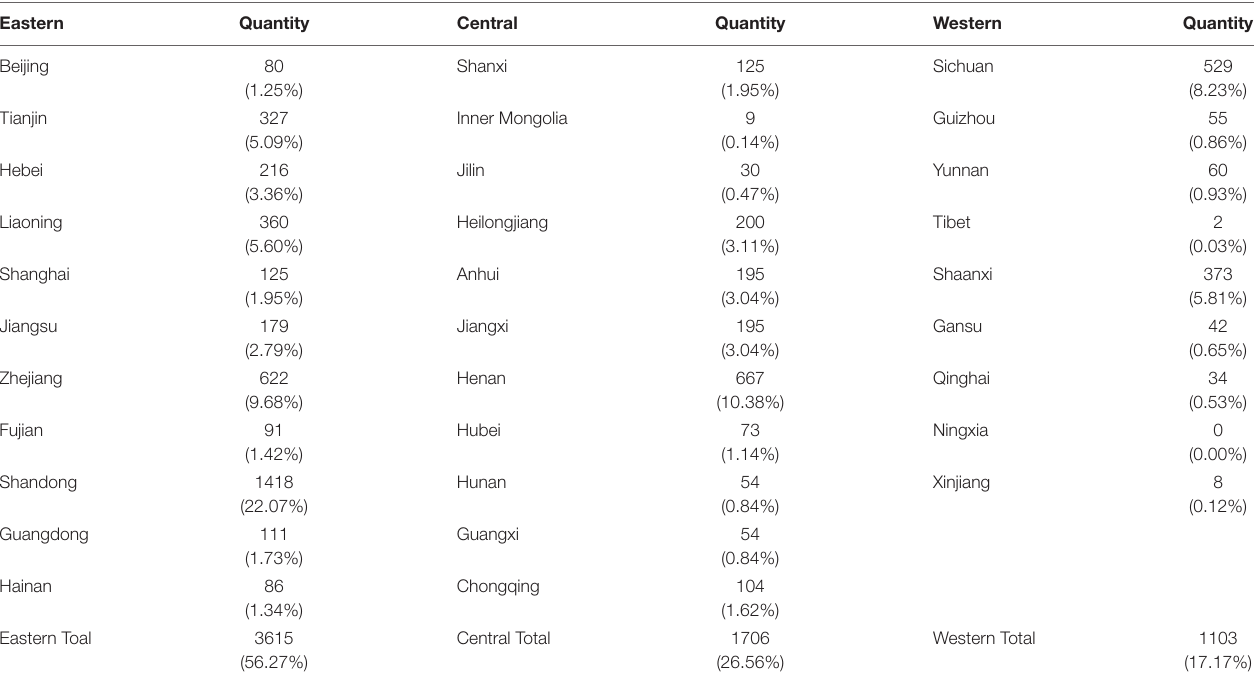
TABLE 2 | Distribution of